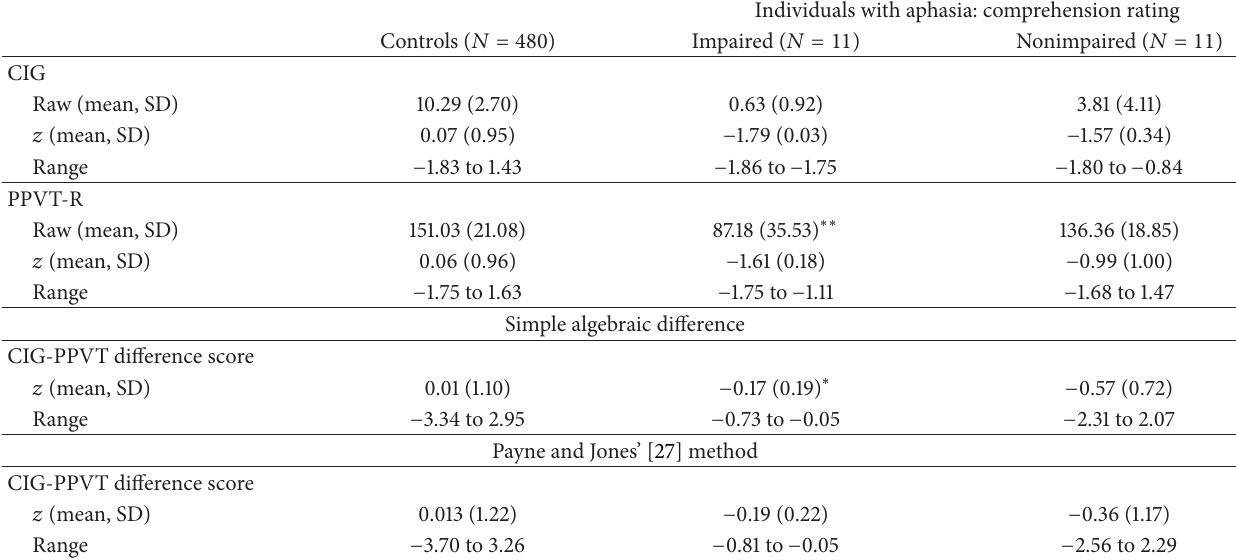
Table 3: Performance of patients presenting with and without comprehension deficits and controls on the demographically adjusted CIG, PPVT-R, and CIG-PPVT-R difference scores.